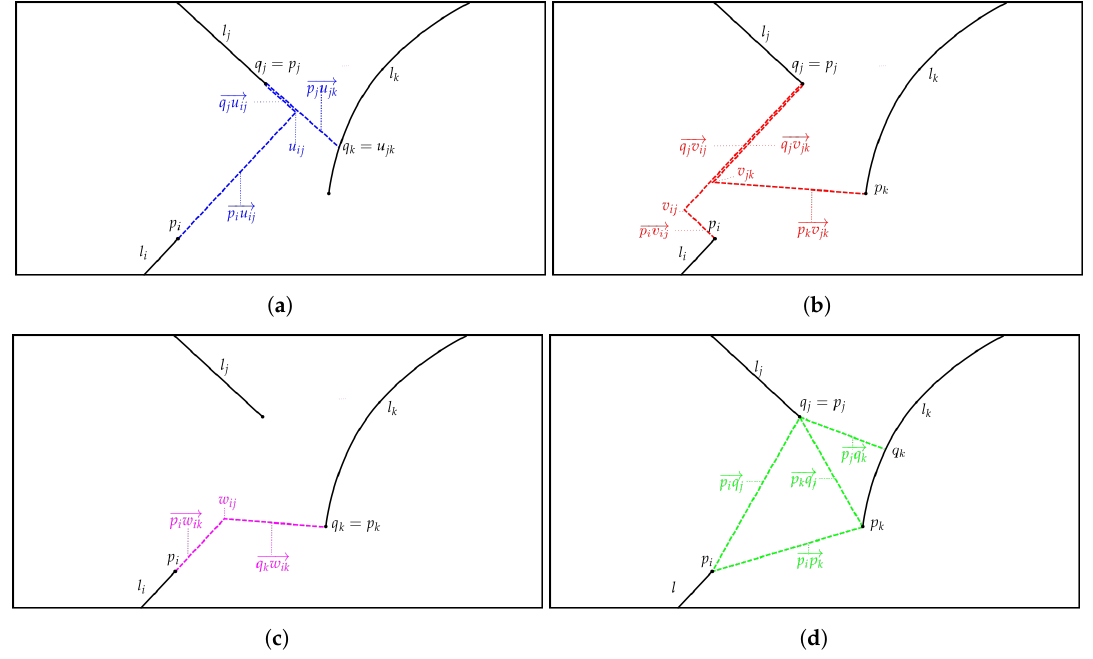
Figure 4. Potential connections in a configuration with 3 walls. The reoccurring elements in each figure are the partial wall axes L = { l i , l j , l k } (black), their wall segments and the floor segments (purple). ( a ) Intersecting connection ( b ) Orthogonal connection ( c ) Blended connection ( d ) Direct